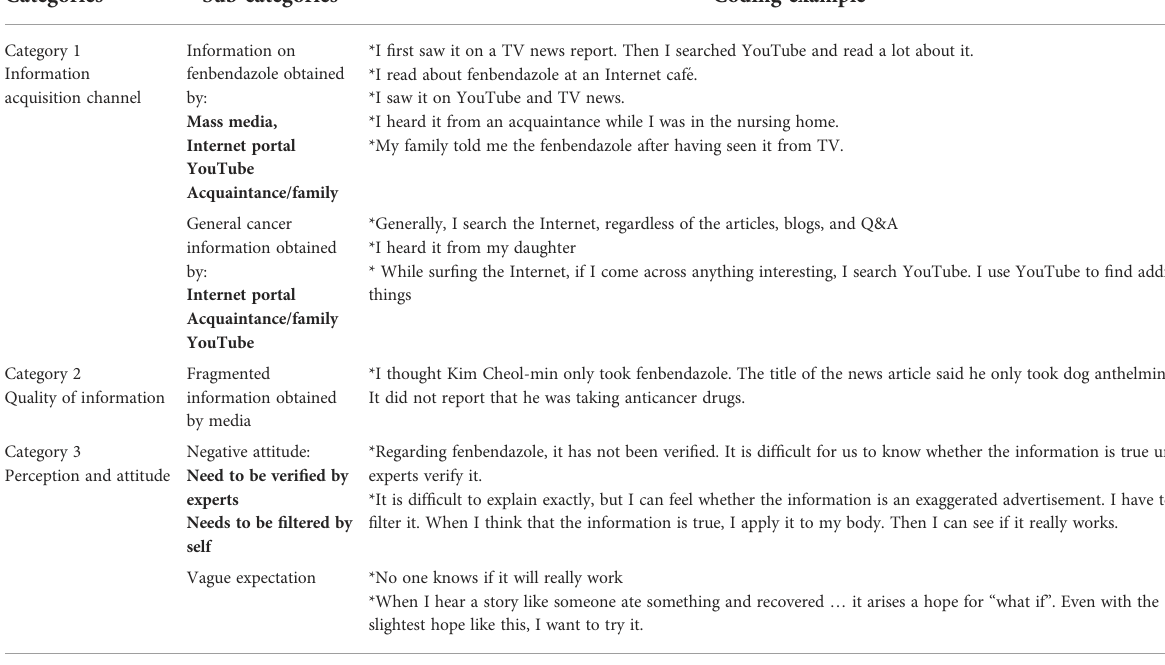
TABLE 2 Categories and sub-categories with coding